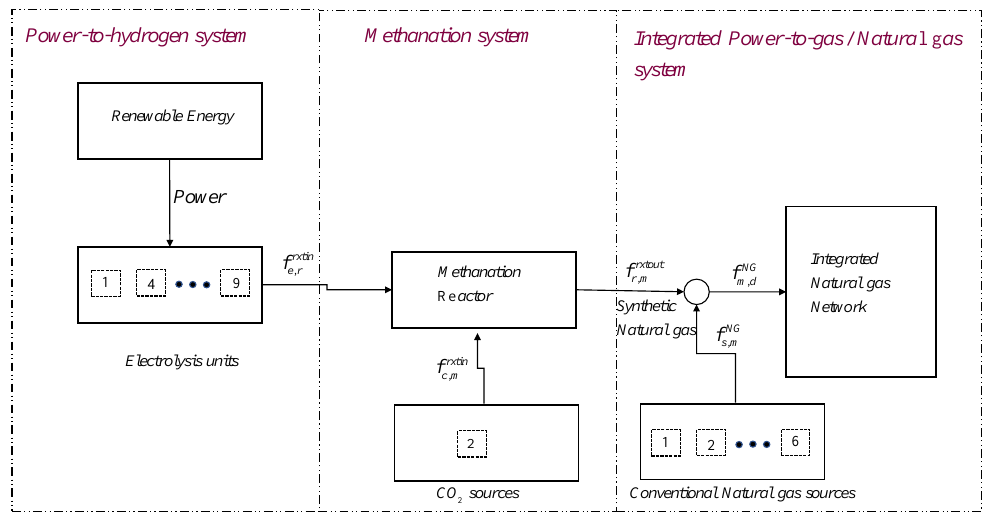
Figure 4. Process description for methanation in natural gas networks (Case A).